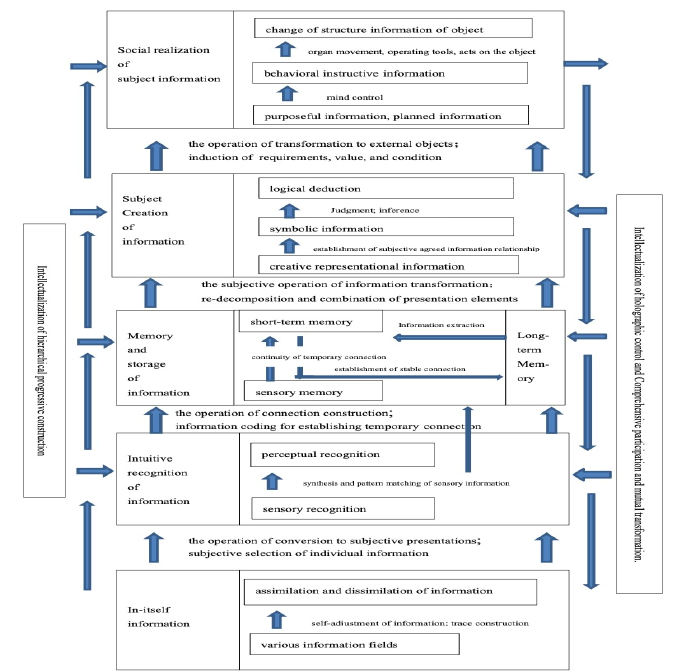
Figure 1. Levels of Human Information activities and Interactions between these levels under Intelligent guidance [8].